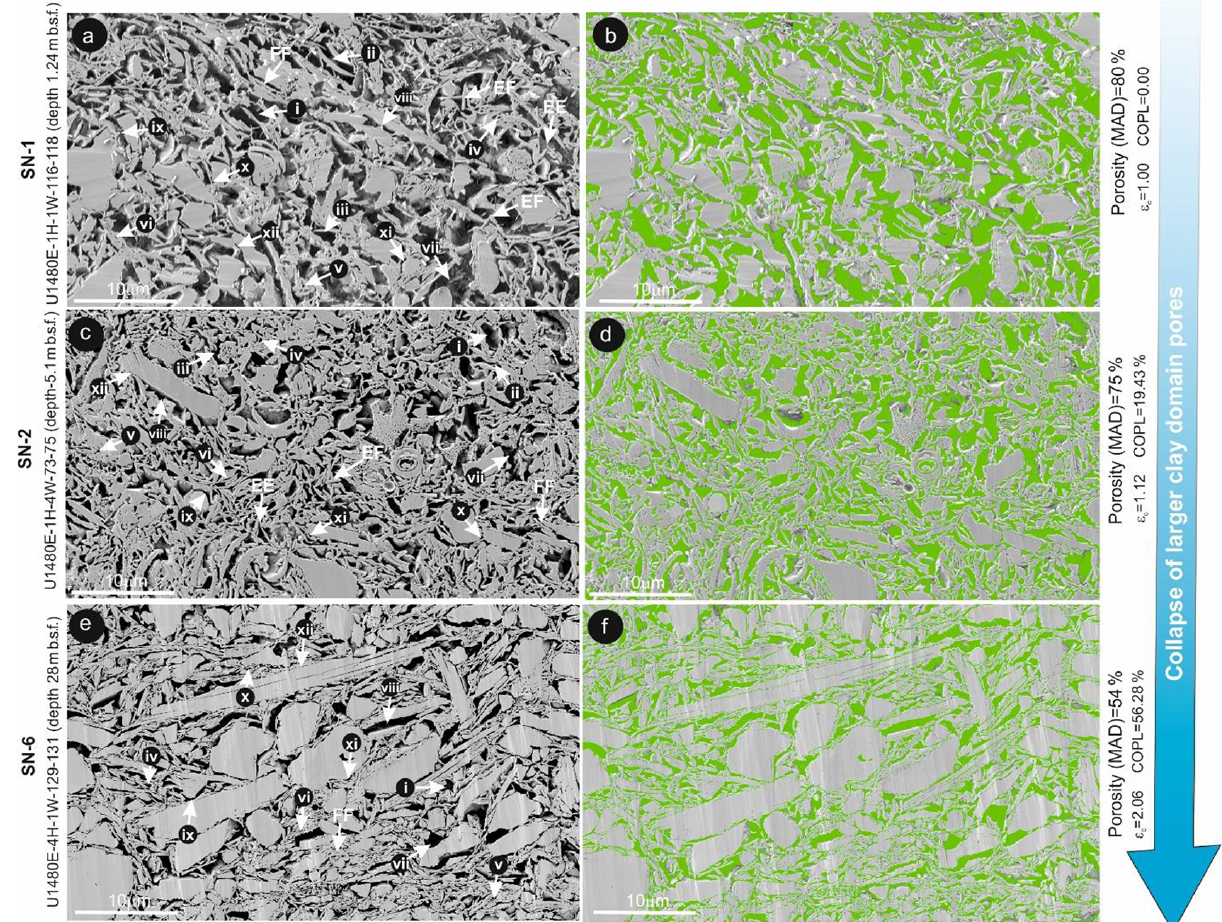
Figure 5. Microstructural overview (BIB–SEM) of samples SN-1 ( a and b ), SN-2 ( c and d ), and SN-6 ( e and f ). Green represents segmented pores of the corresponding microstructure of the sample. (i) Equant large clay-domain pores, (ii) elongated large clay-domain pores, (iii) crescent-shaped large clay-domain pores, (iv) equant small clay-domain pores, (v) crescent-shaped small clay-domain pores, (vi) elongated small clay-domain pores, (vii) equant large silt-adjacent pores, (viii) elongated large silt-adjacent pores, (ix) crescent-shaped large silt- adjacent pores, (x) equant small silt-adjacent pores, (xi) crescent-shaped small silt-adjacent pores, (xii) elongated small silt-adjacent pores. EE: edge-to-edge contact, EF: edge-to-face contact, and FF: face-to-face